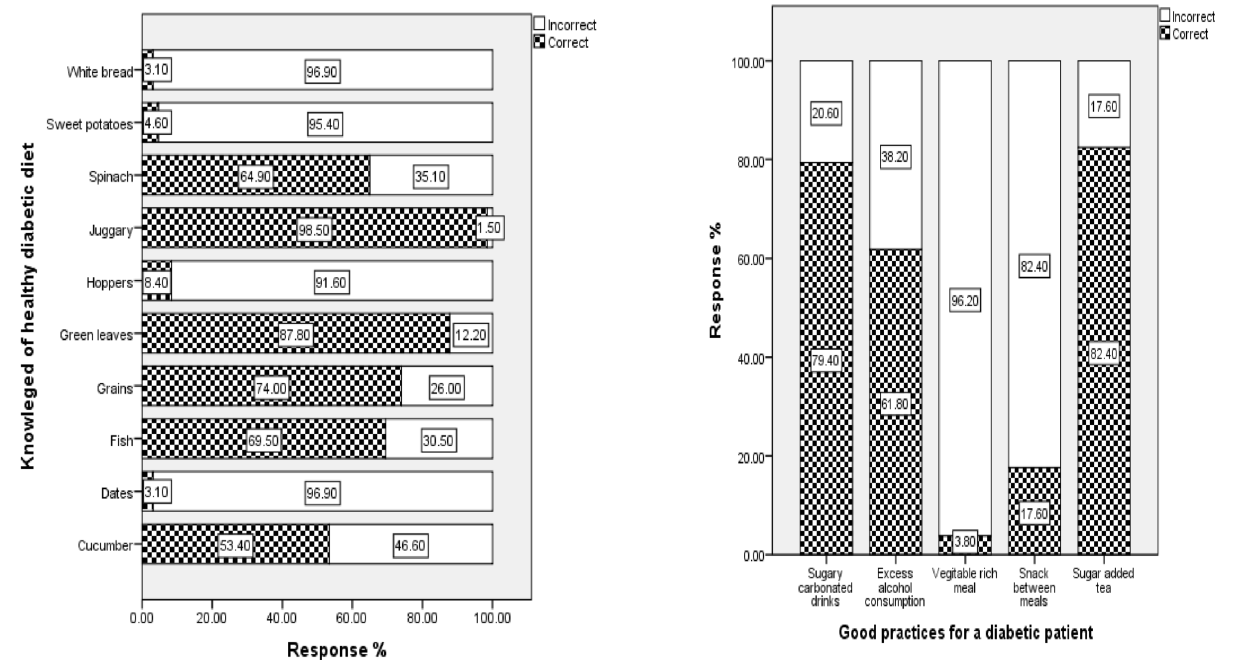
Figure 2B: Lifestyle modifications for blood sugar